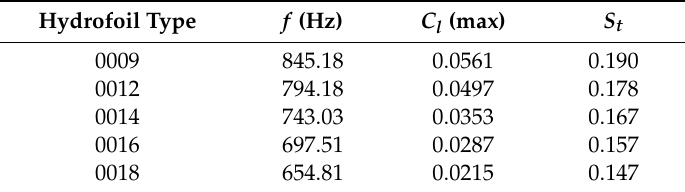
Table 7. Results obtained after changing the thickness of the